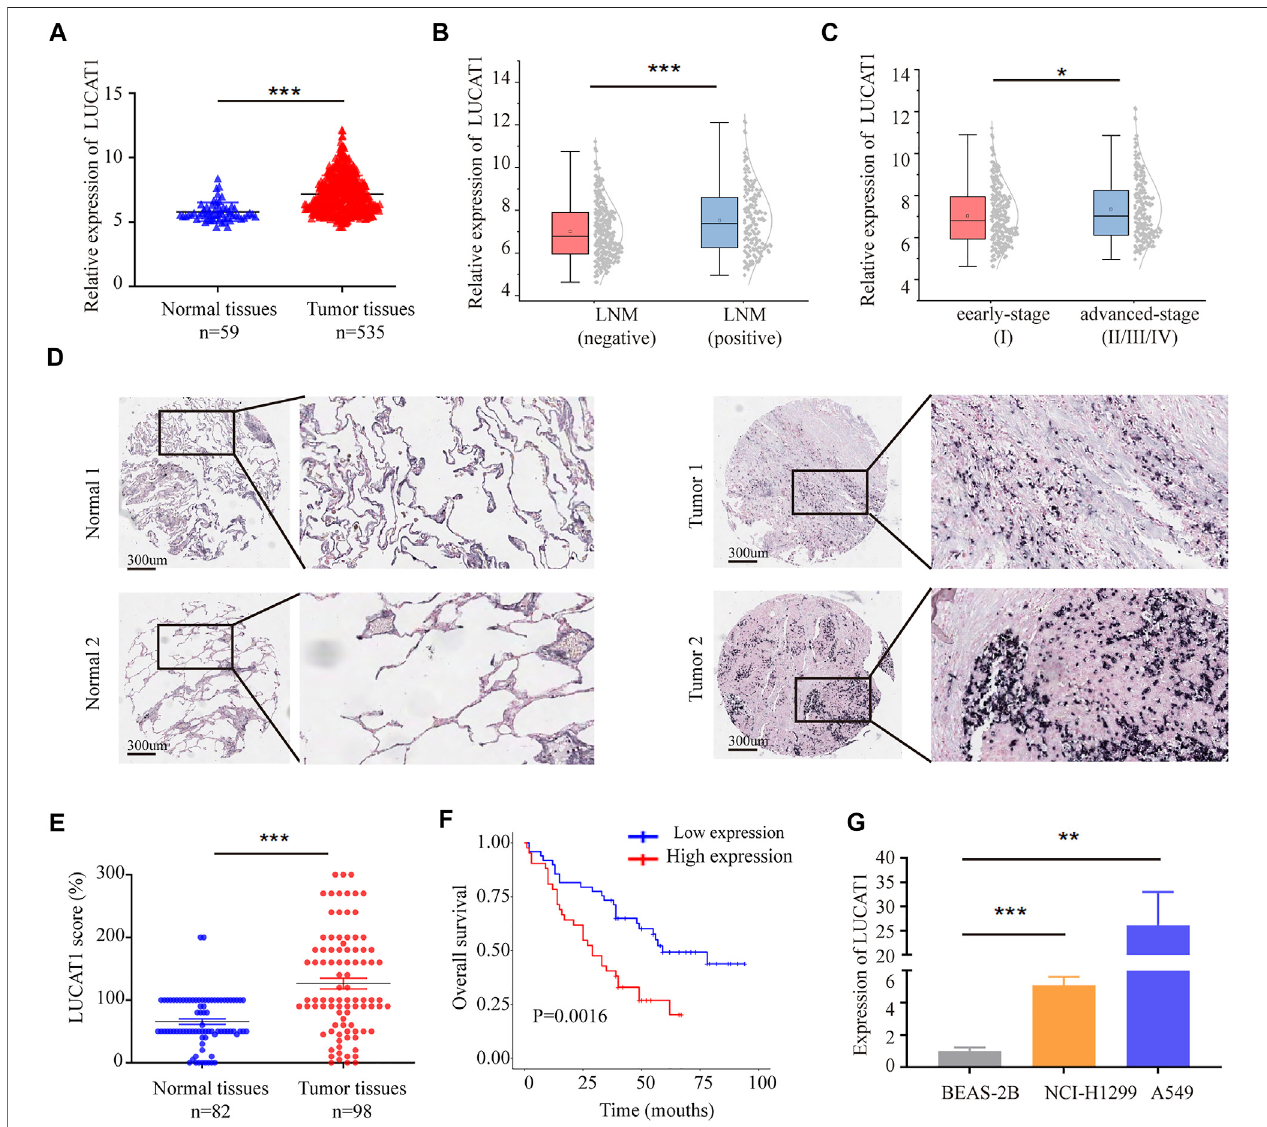
FIGURE2| LUCAT1wasupregulated inLUADtissues,and itsoverexpression correlateswithpooroutcome ofLUAD. (A) Relativeexpression ofLUCAT1inLUAD compared with normal tissues was analysed by using TCGA datasets. (B) Relative expression level of LUCAT1 in LUAD with lymph node metastasis and non-lymph nodemetastasis. (C) ExpressionlevelofLUCAT1inearly-stageLUADpatients(stageI)withadvanced-stageLUADpatients(stageII/III/IV). (D,E) ISHanalysisofLUCAT1 expressioninLUADtissues( n =98)andnormaltissues( n =82),Scalebar:300 µm. (F) Kaplan-MeieranalysisforoverallsurvivalofLUADpatientswithlowandhigh LUCAT1expression( p =0.0016). (G) qRT-PCRwasperformedtodetecttheexpressionofLUCAT1innormallungepithelialcellsandLUADcells.Atwo-tailedstudent ’ s t-test was used to analyse the comparison between the two groups (* p < 0.05; ** p < 0.01; *** p < 0.001).